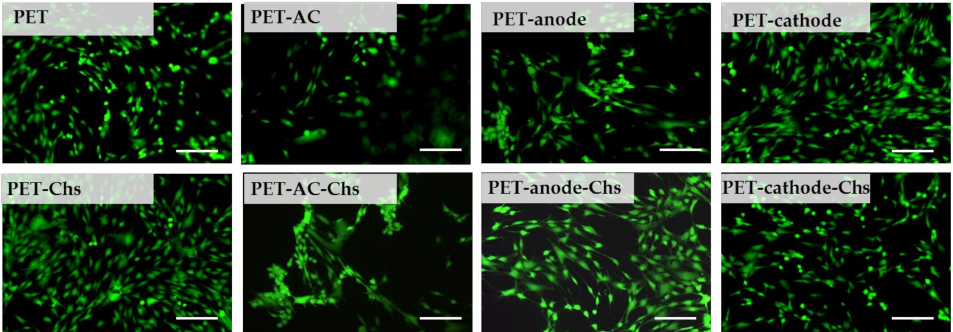
Figure 4. Morphology of human mesenchymal stem cells on initial and plasma-treated PET films as well as ones coated with chitosan (48 h in culture). Scale bar is 100 µ